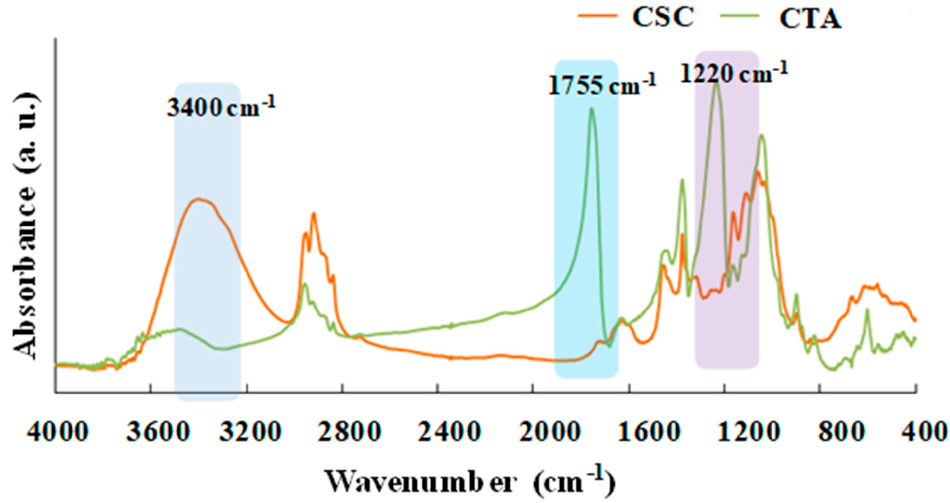
Figure 3. Infrared absorbance spectra of CSC and CTA.